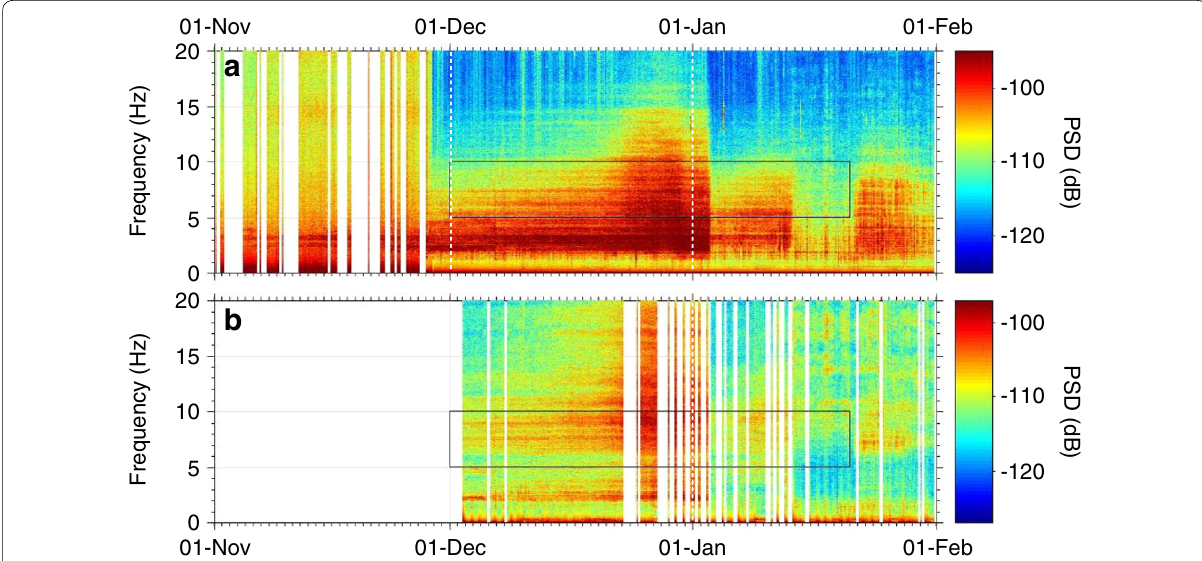
Fig. 5 Spectrograms of continuous tremors. Spectrograms of recorded seismic signals at a SUN and b KAEB calculated in an eight-hour time window with a four-hour overlap. Data gaps shown in white are caused by, for example, seismometer/digitizer failure or errors in data transmission. Black rectangles spanning from 1 December 2013 to 20 January 2014 at a frequency band of 5–10 Hz indicate the data to be